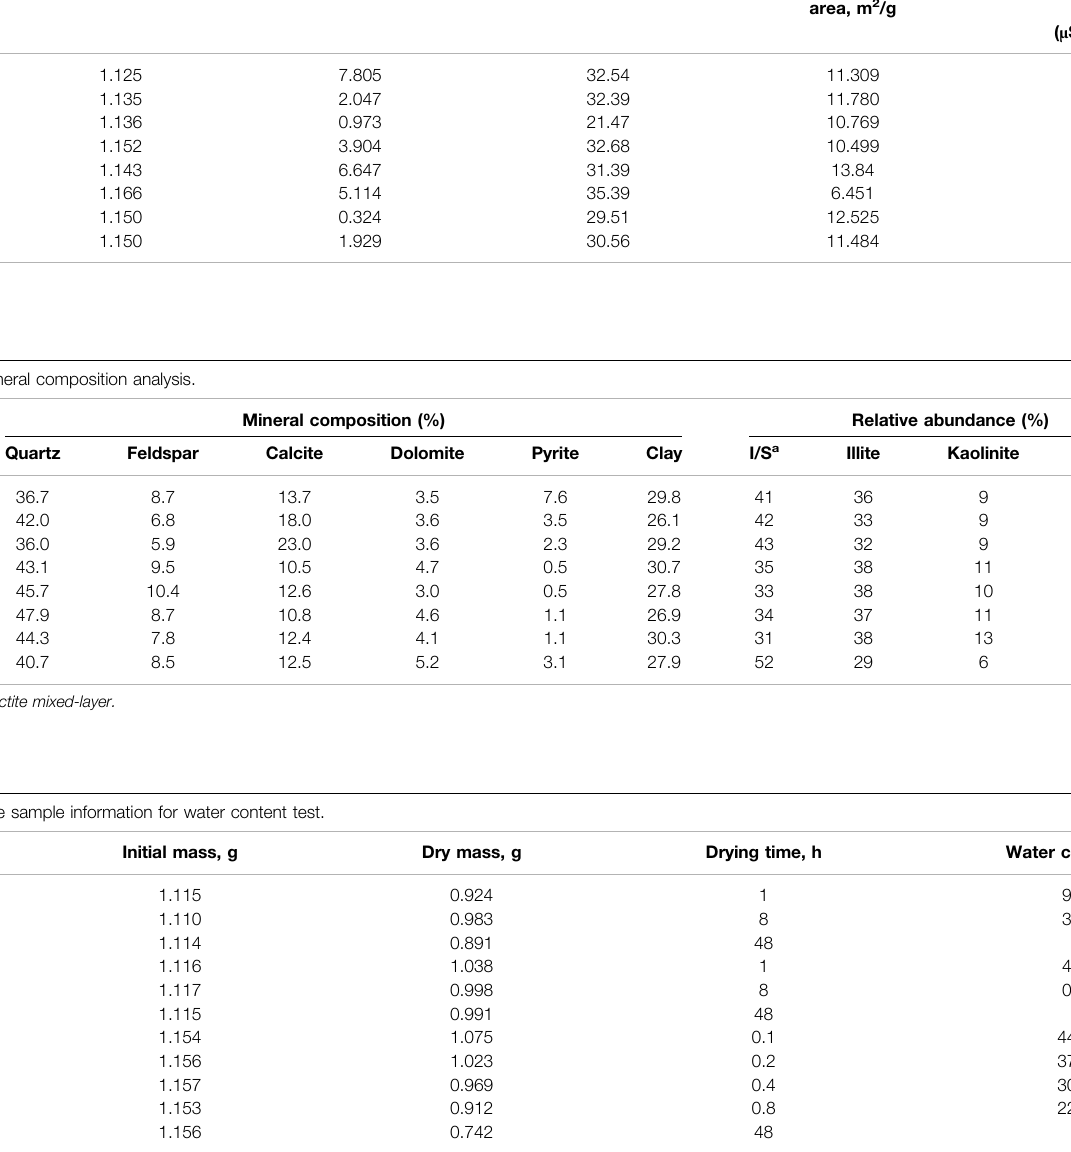
TABLE 1 | The basic information of different sediments. Sample Quality, g